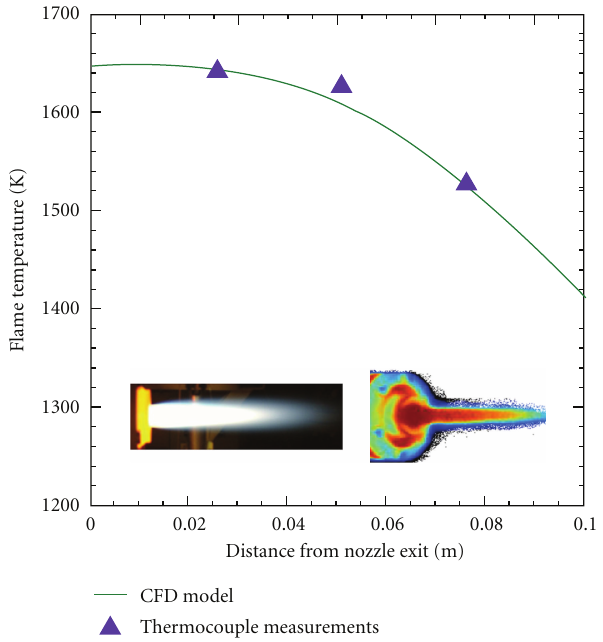
Figure 5: Measured and predicted temperatures versus distance from nozzle exit. Inserts show an optical photograph and an infrared image of the hot central region of the burner-erosion rig flame.